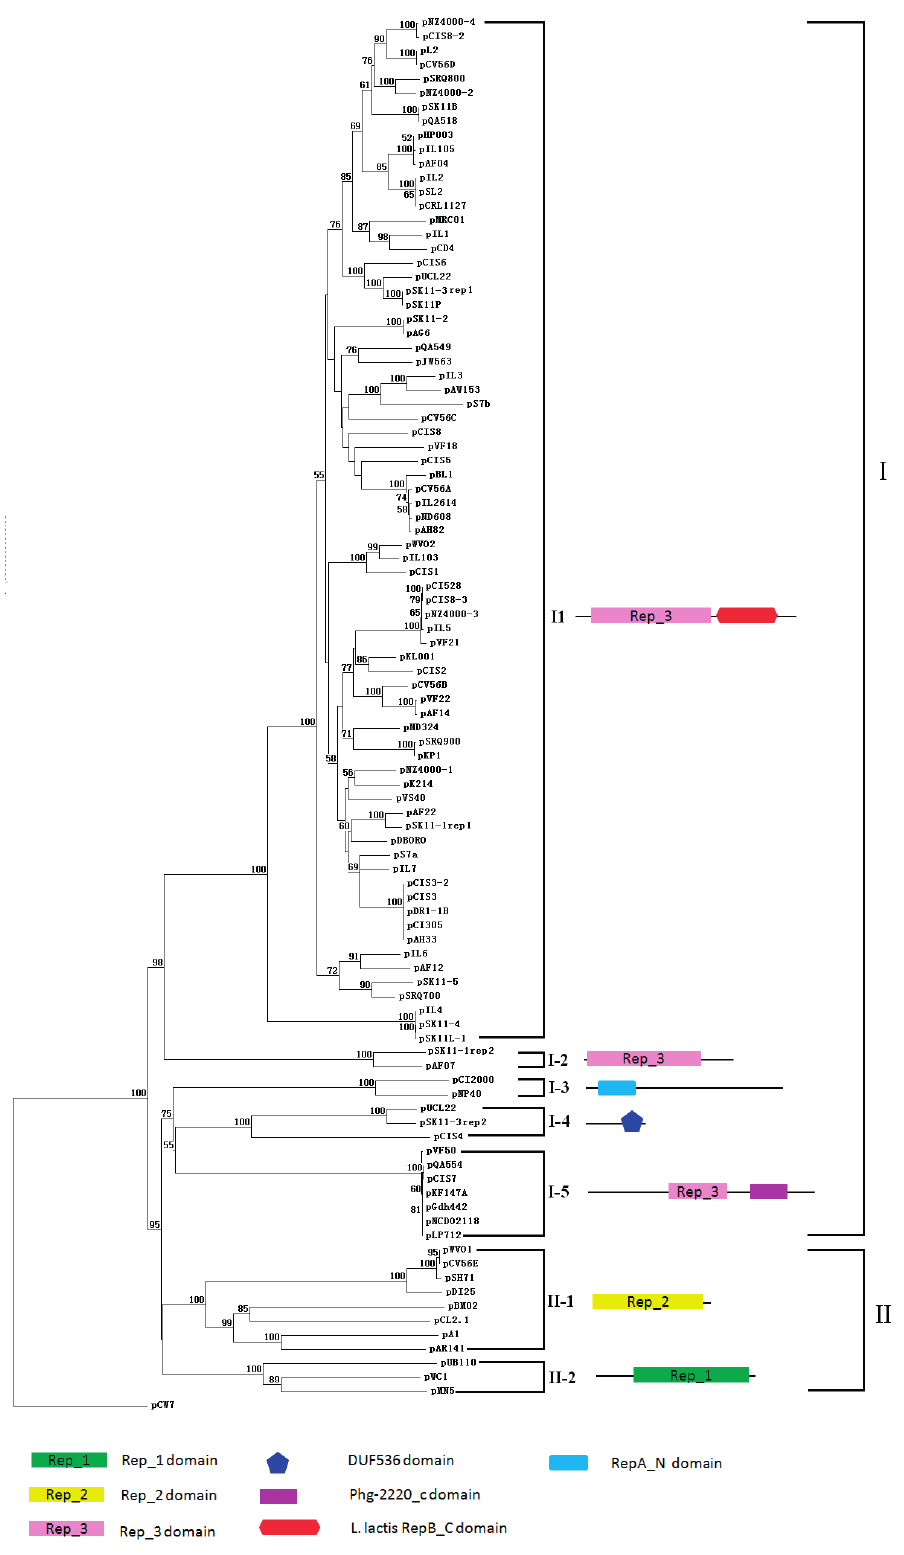
Figure 1. A Neighbor-joining tree was constructed with the ClustalW using Rep proteins from Lactococcus lactis plasmids. Bootstrap values for a total of 100 replicates are shown at the nodes of the tree. The plasmid pCW7 (a pT181 type RCR plasmid) was used as an out-group. Bar 1% sequence